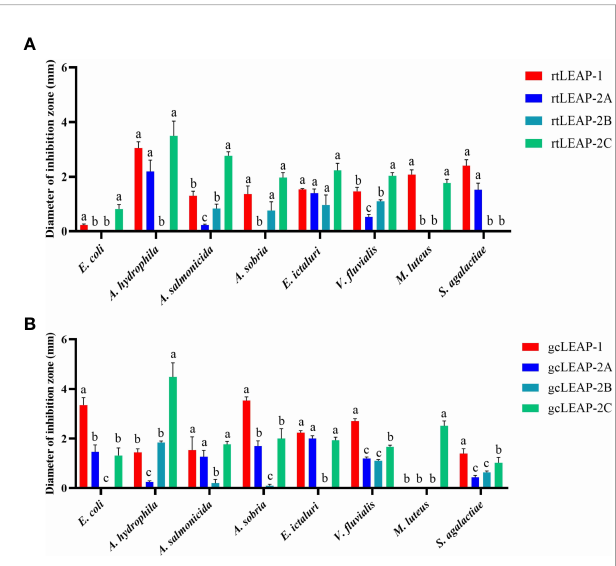
FIGURE 5 Antibacterial activities of rainbow trout (A) and grass carp (B) LEAPs against various bacteria. The underlay agarose gel containing E. coli ATCC25922, A. hydrophila XS91-4-1, A. salmonicida BG1, A. sobria CR79-1-1, E. ictaluri HSN-1, V. fl uvialis WY91-24-3, M. luteus ATCC10240 and S. agalactiae ATCC13813 respectively was poured into sterile petri dishes. After the solidi fi cation, 4 mm diameter wells were punched in the agarose gel. Then 6 m L LEAP (125 m M) was added to each well, and sterile water was added as the control. Plates were incubated at the optimum bacterial growth temperature (28 ℃ for A. hydrophila, A. salmonicida, A. sobria and E. ictaluri or 37 ℃ for E. coli, V. fl uvialis, M. luteus and S. agalactiae ) for 3 h, and then the underlay agarose gel was covered with overlay agarose gel. The diameter of the inhibition zone around each well was measured after 24 h of incubation at the optimum bacterial growth temperature. Data represent the mean ± SEM of three independent experiments. Different letters indicate signi fi cant differences